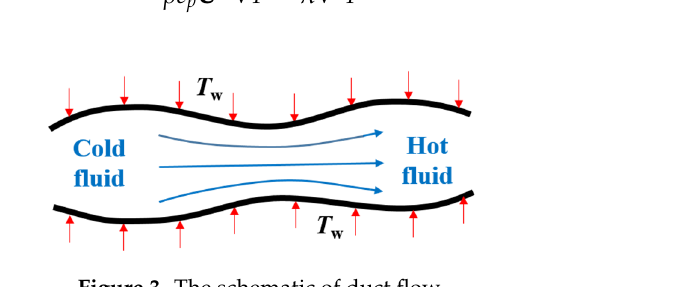
Figure 3. The schematic of duct flow.